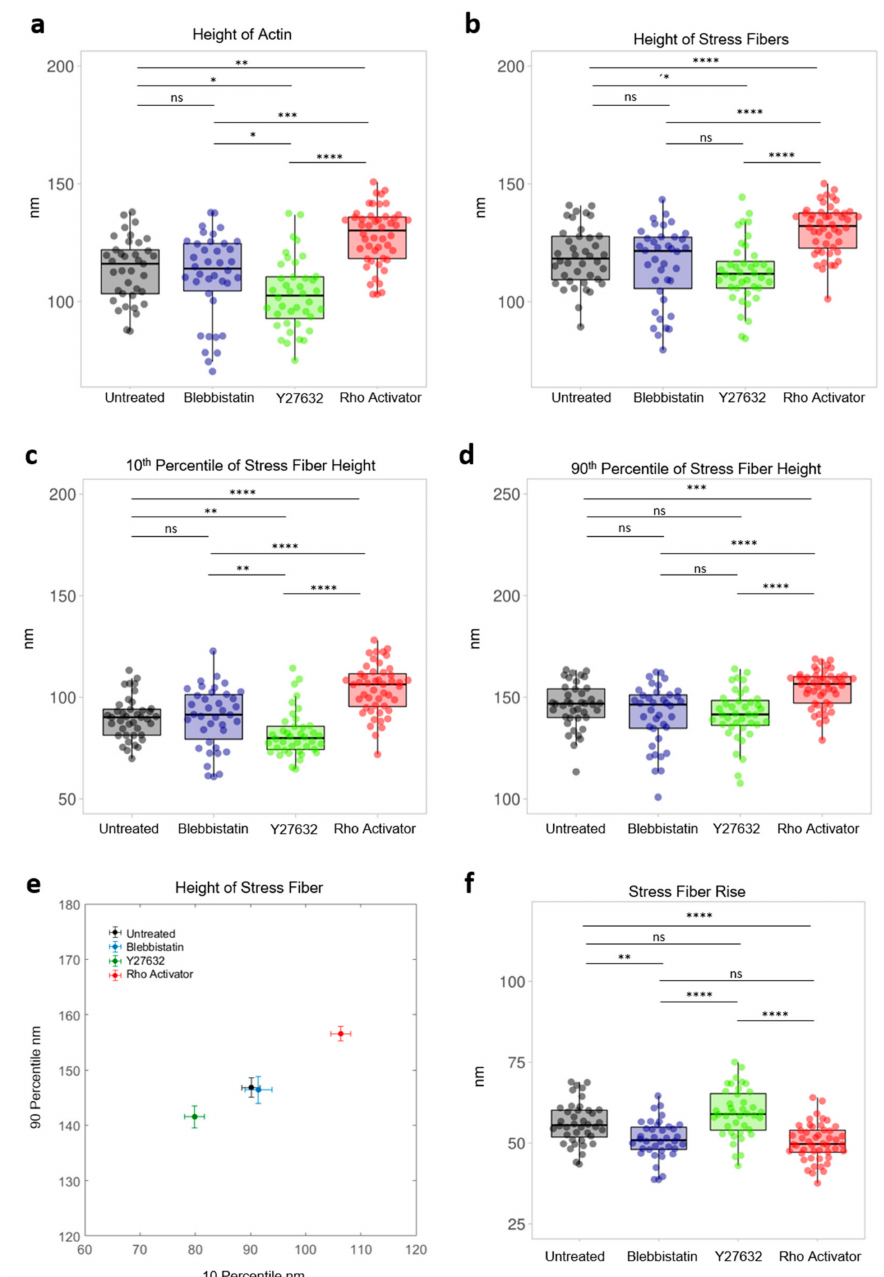
Figure 3. Height analysis of the actin cytoskeleton. Each dot represents the median of a single cell. ( a ) Height of Actin of untreated and blebbistatin, Y27632, Rho aActivator-treated cells. ( b ) Height